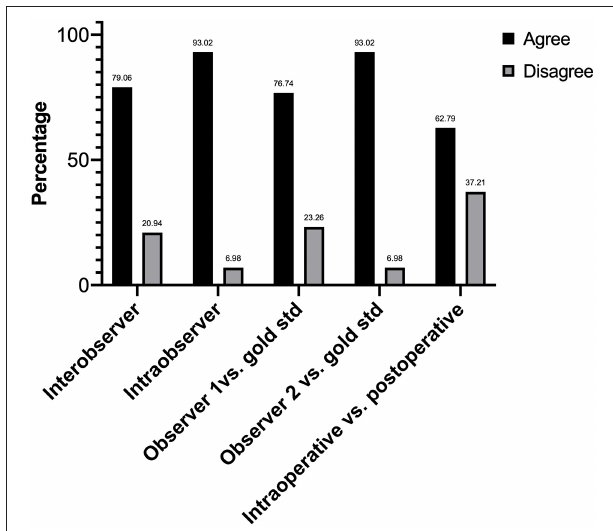
FIGURE 2 | Histogram showing the frequencies of agreement and disagreement of scores in interobserver test, intraobserver test, comparing observers to the gold standard, and evaluating observer settings. All frequencies are statistically significant ( P <